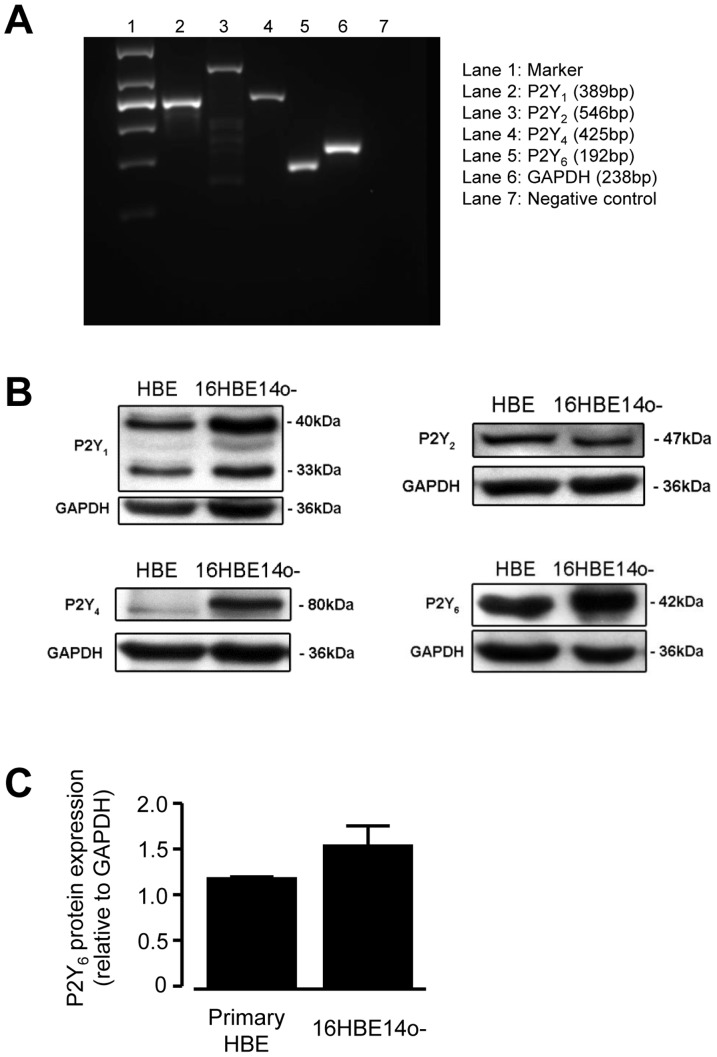
Detection of mRNA and protein expression of P2Y receptor subtypes.(A) Amplification products of the predicted size were found after RT-PCR of primary human bronchial epithelial (HBE) cells. Representative agarose gel showing the products of P2Y1 (lane 2, 389 bp), P2Y2 (lane 3, 546 bp), P2Y4 (lane 4, 425 bp), and P2Y6 (lane5, 192 bp) subtype-specific PCR products. Lane 1, 100 bp molecular weight standard; lane 6, negative control (without reverse transcription). (B) Western blots of P2Y receptor subtypes in primary HBE cells and the 16HBE14o- cell line. Expression of P2Y1 (40 kDa), P2Y2 (47 kDa), P2Y4 (80 kDa), and P2Y6 (42 kDa) receptors are shown (lane 1). For P2Y1, an additional lower molecular weight product (33 kDa) was also found. (C) P2Y6 receptor protein expression was not statistically different between primary HBE cells and the 16HBE14o- cell line (n = 3, p<0.05, Student’s t-test).